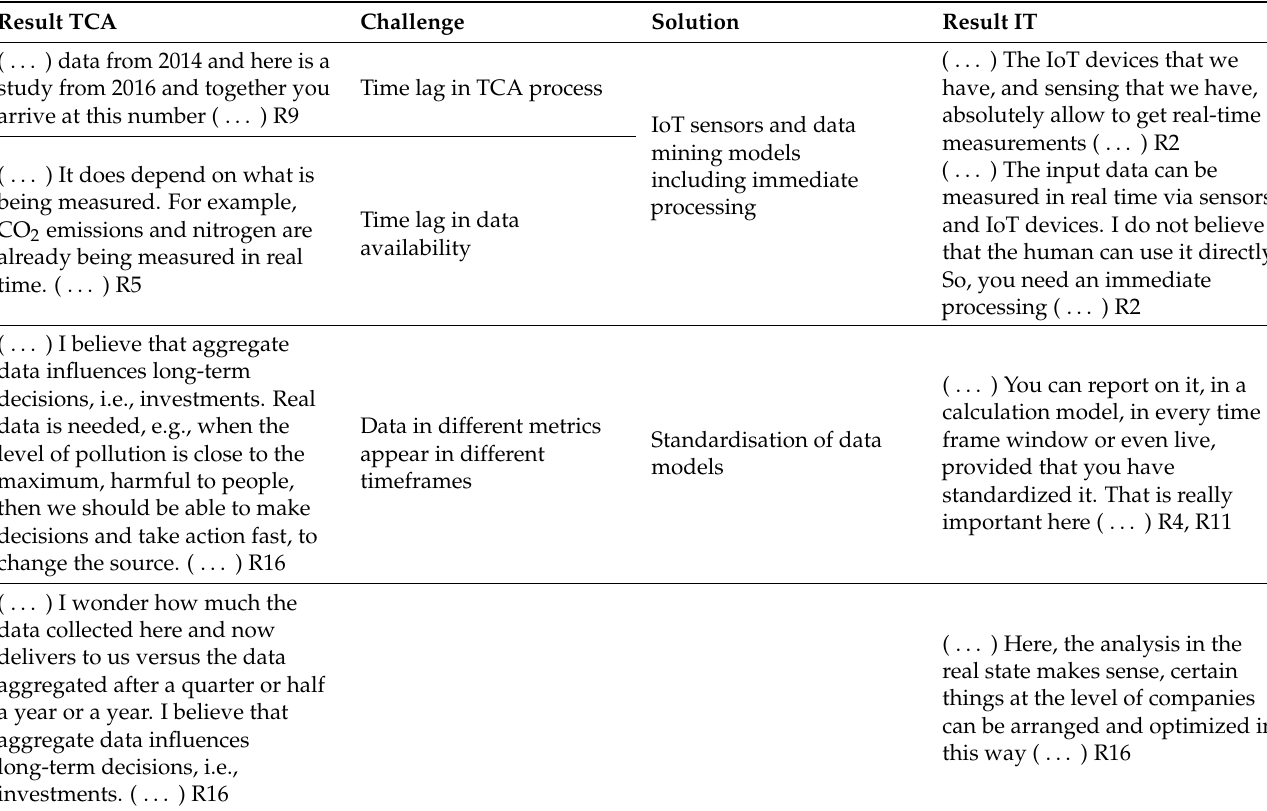
Table 5. TCA timeliness and